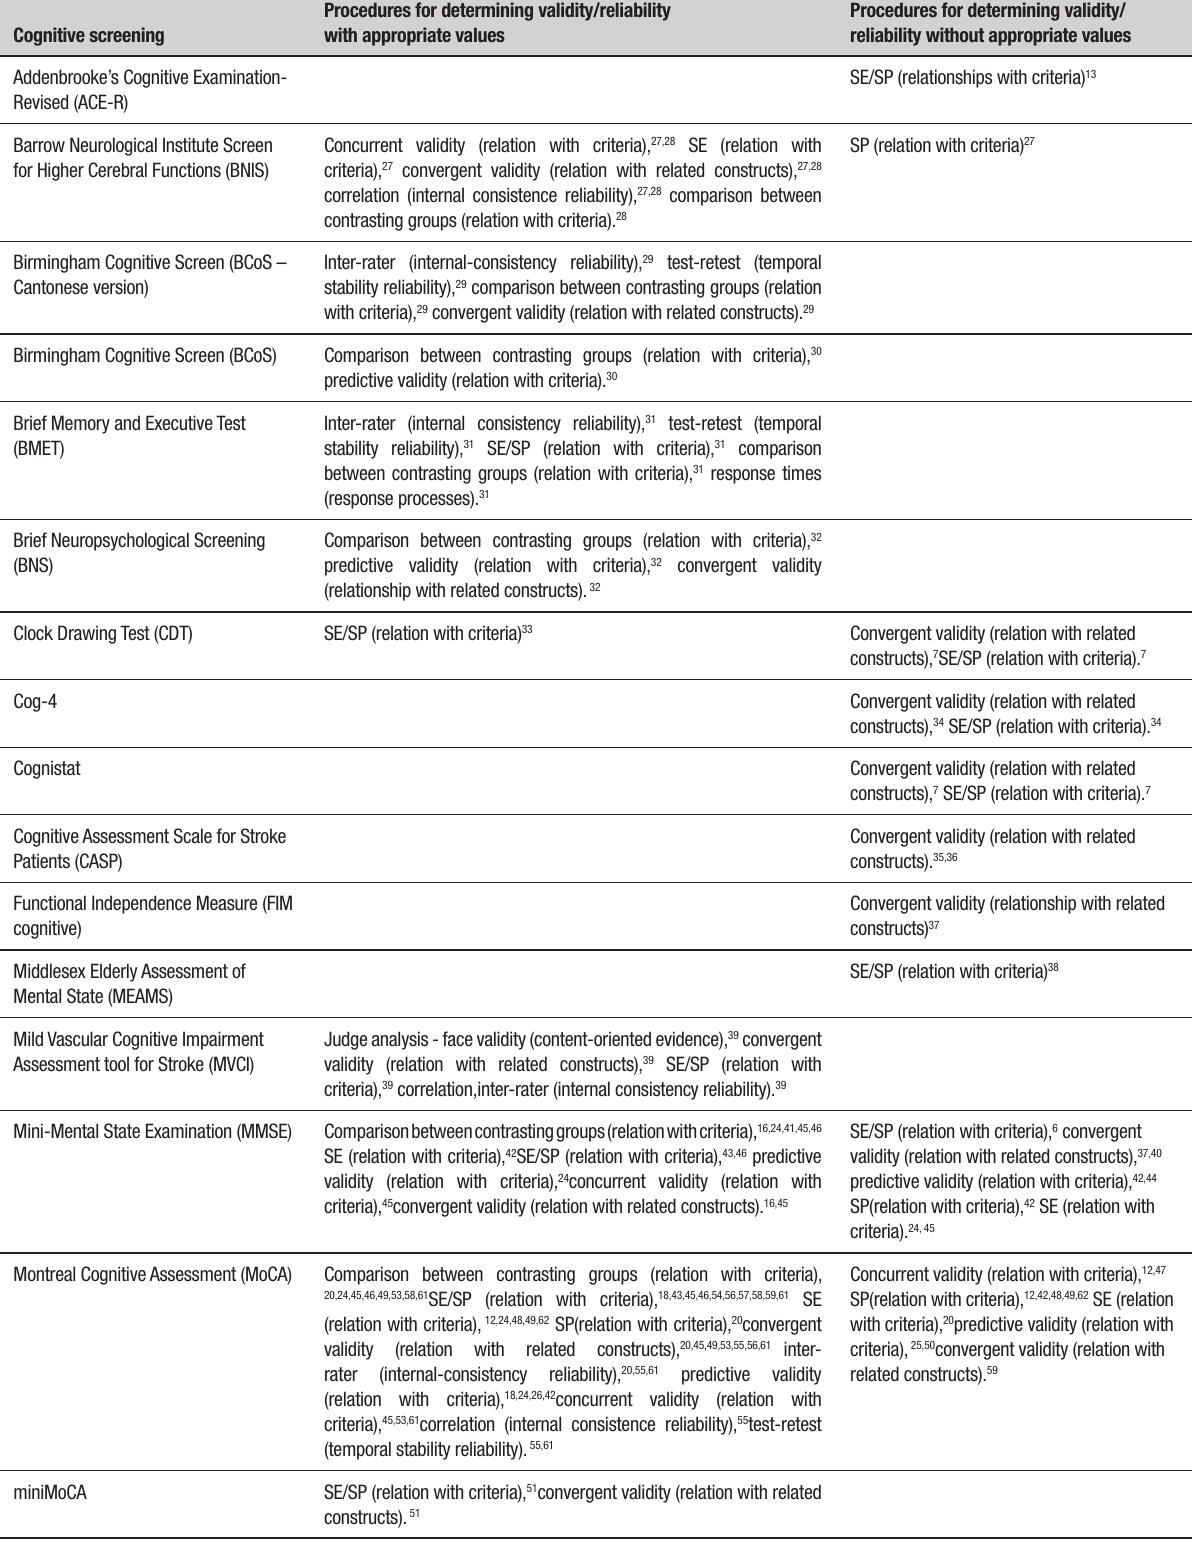
Table 2. Cognitive screenings,procedures for determining